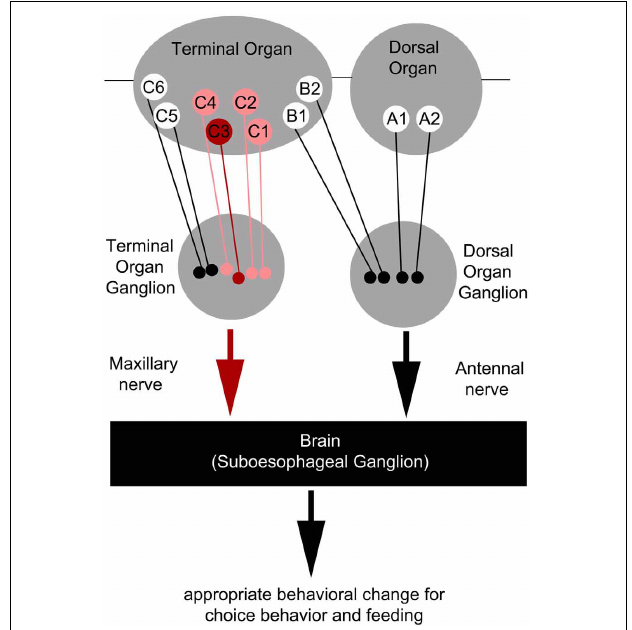
FIGURE 6 | Schematic overview of the neurons signaling quinine-dependent bitter taste in Drosophila larvae. According to Kwon et al. (2011), GRs are expressed in only 10 neurons of the two major chemosensory organs of the larva, the dorsal organ (DO) and the terminal organ (TO). The two GRNs of the DO are called A1 and A2 (DO group). Additionally, B1 and B2, which are located in the dorsolateral group of sensilla of the TO, have their cell bodies sitting in the DO ganglion (TO dorsolateral group). C1–C6 located in the distal group of sensilla of the TO have their cell bodies located in the TO ganglion (TO distal group). Bitter quinine taste information affecting larval choice behavior is mediated mainly by the TO neurons C1–C4 (pink) and especially by the single TO neuron C3 (red). Signals reach the subesophageal ganglion via the maxillary nerve. Output of the single C3 neuron is necessary for quinine-dependent avoidance and artificial activation of the C3 neuron is sufficient to elicit aversive choice